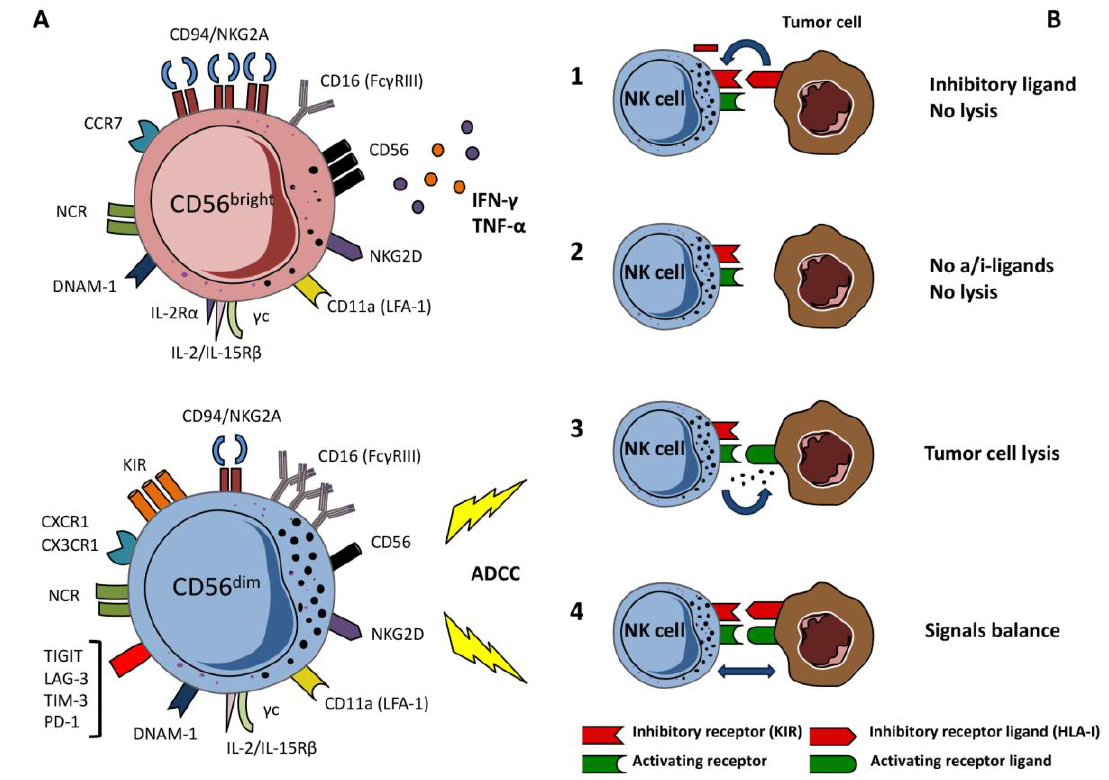
Figure 1. Natural Killer (NK) cells subsets and their functions. ( A ) NK cells subsets: CD56 dim cytotoxic NK subset express low levels of CD56 molecule and are able to perform antibody-dependent cellular cytotoxicity (ADCC) thanks to the high expression of CD16 receptor; CD56 bright NK subset express high levels of CD56 molecule and is capable to produce interferon- γ (IFN- γ ) and TNF- α , thus contributing to the activation of monocytes and Th1 response. ( B ) NK cells exert cytotoxic activity and cytokines release through a balance between activating and inhibitory receptors: ( 1 ) The target cell cannot express ligands for activating receptor and express normal levels of Human Leukocyte Antigen class I molecules (HLA-I) blocking NK cell response; ( 2 ) In the absence of HLA class I molecules NK cell cytotoxicity can be inhibited by the lack of expression of activating receptor ligands on tumor cells; ( 3 ) NK cell activity is exerted by the binding of ligand to activating receptor and thanks to the lack of HLA-I molecules on target cell; ( 4 ) The normal expression of both ligands leads to a dynamic balance between NK cell and target